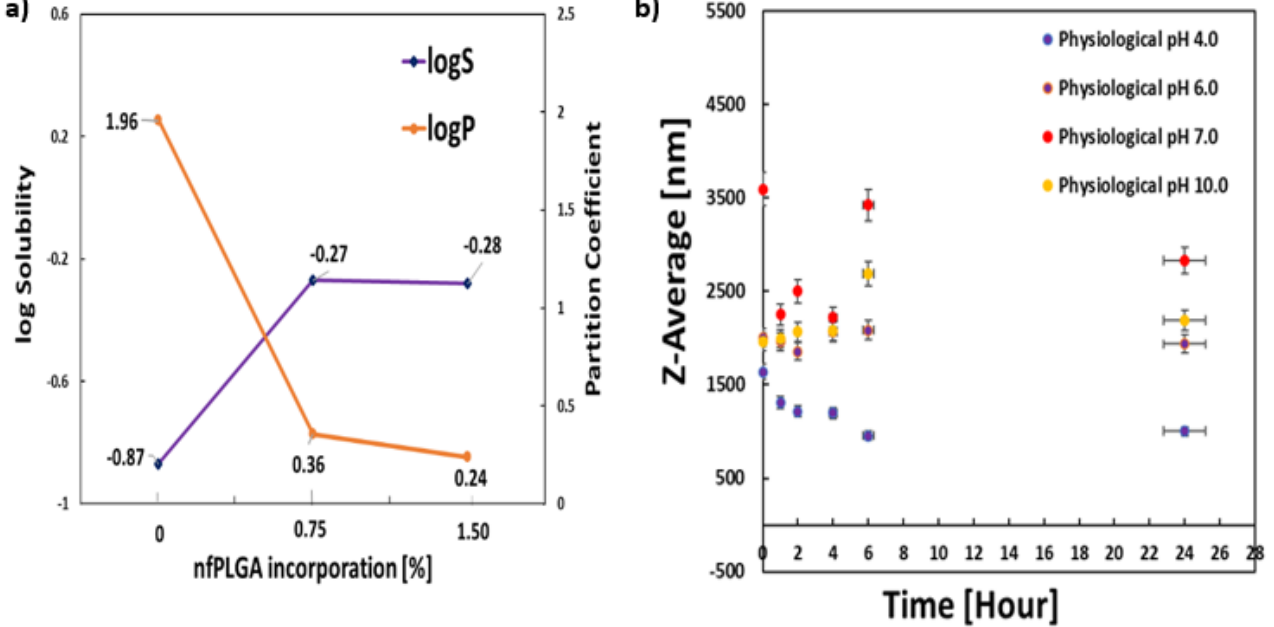
Figure 4. ( a ) Experimental study of solubility and partitioning coefficient and ( b ) Stability of the DMX- nf PLGA in a physiological pH buffer.